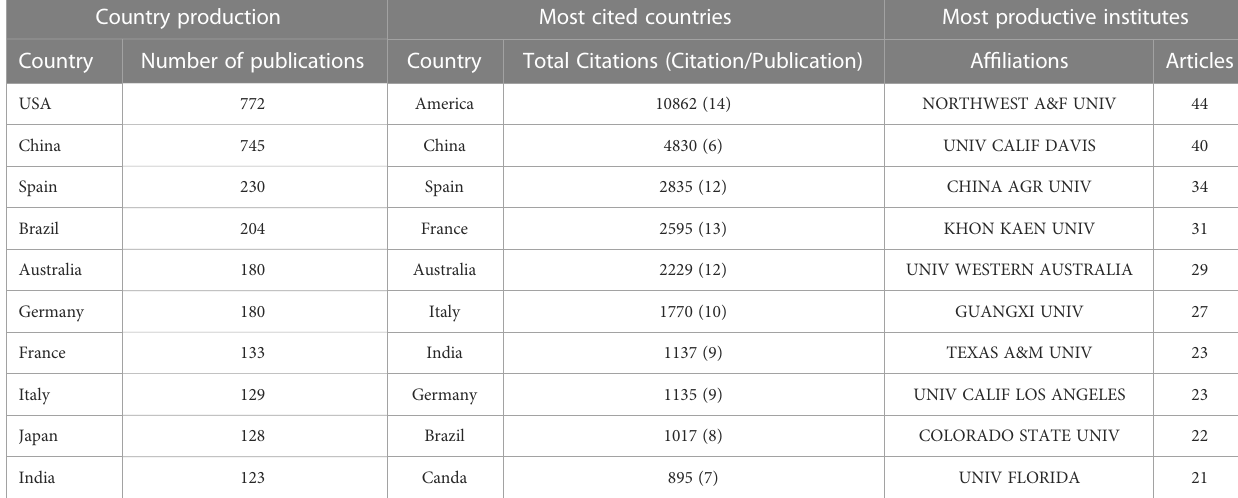
TABLE 3 Top 10 most productive and cited countries and most productive institutes with the publications of root plasticity during drought and recovery research during the period of 1900 – 2021. Country